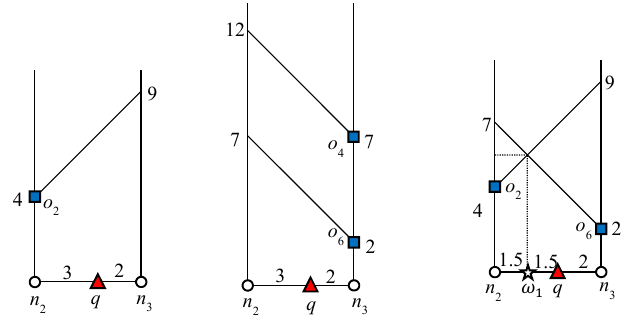
Figure 8. Determination of safe exit point ω 1 .